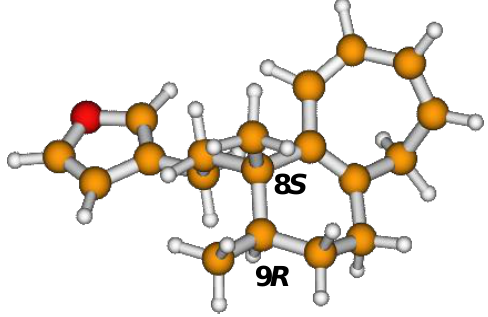
Figure 6. Minimum B3LYP/6-311+G(d,p) energy structure of 8-(2-furanethyl)-8 S ,9 R -dimethylbicyclo[5.4.0]undeca-1,3,5-triene or dodovisate C ( 1 ) isolated from essential oil of Dodonea viscosa leaves.